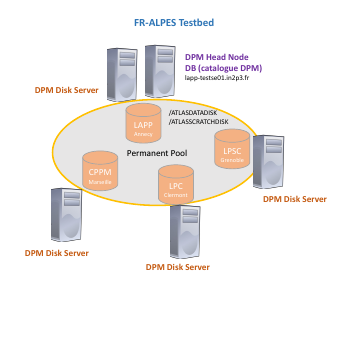
Figure 1. Components of the FR-ALPES